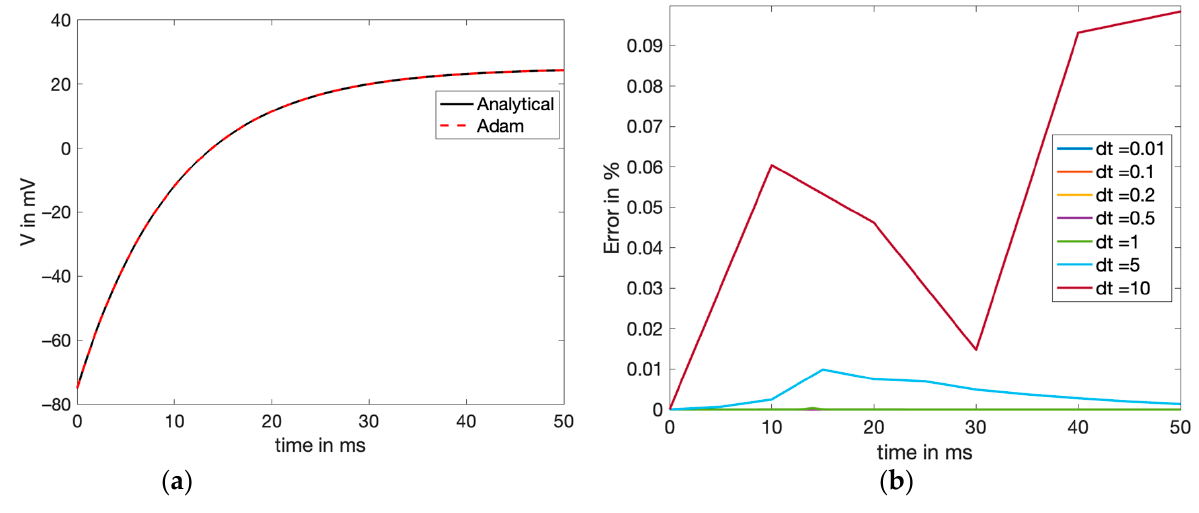
Figure 6. ( a ) AB4-AM4 method comparison with the exact (analytical) solution, both plotted to approximate the voltage in the membrane with the DC input current, and ( b ) error comparison (exact-calculated) for different step size values of the AB4-AM4 numerical solution .